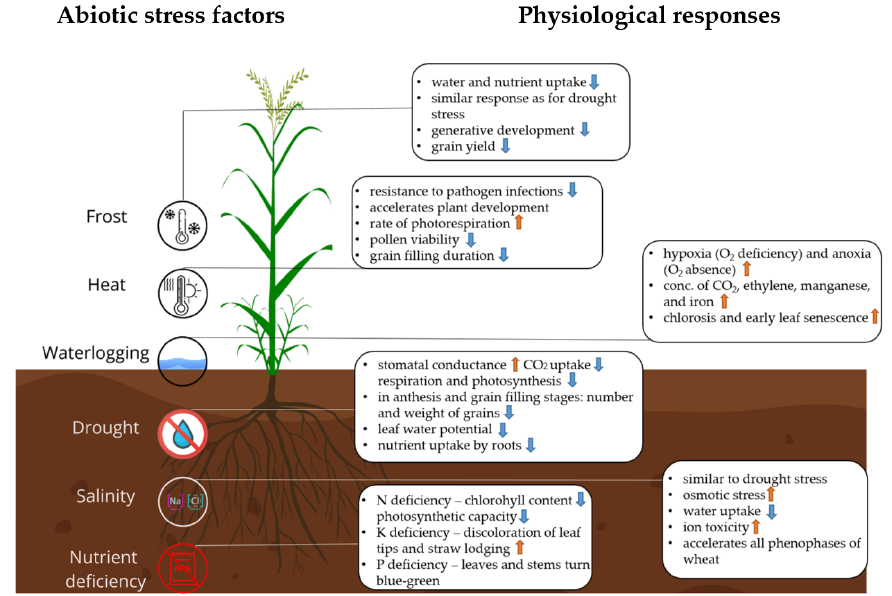
Figure 1. Abiotic stress factors (frost, heat, waterlogging, drought, salinity and nutrient deficiency) and corresponding physiological responses of winter wheat ( ↑ symbol represents increase and ↓ symbol represents decrease).